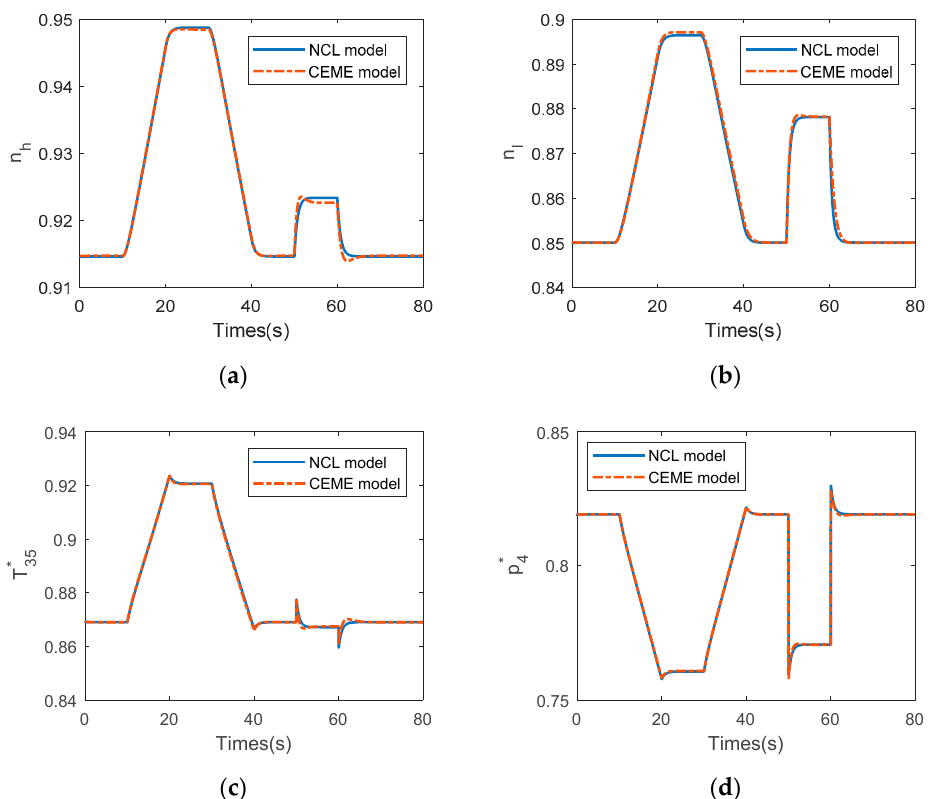
Figure 12. Dynamical behaviors ( a ) n h , ( b ) n l , ( c ) T ∗ and ( d ) 𝑝 (cid:2872)∗ of the CEME model and the NCL model.